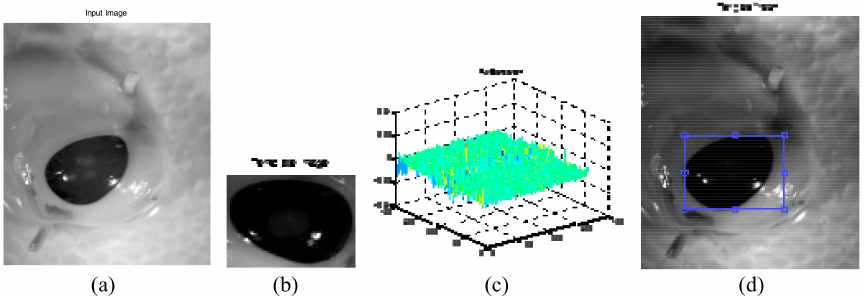
Figure 12. Template matching-FFT based correlation. ( a ) input image; ( b ) template image; ( c ) correlation plot, and ( d ) template matched.